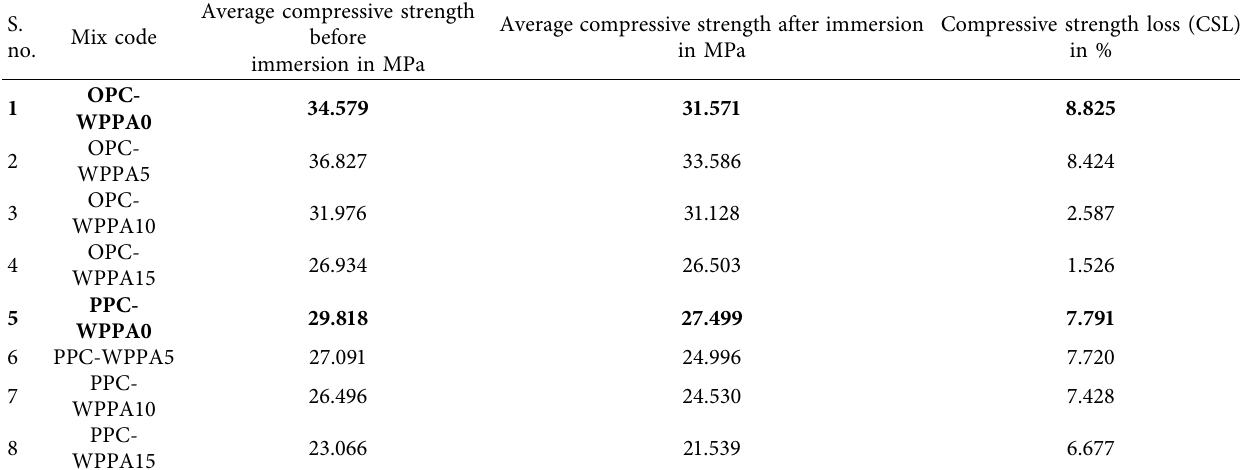
Table 15: Compressive strength loss (CSL) of OPC-WPPA and PPC-WPPA concrete cured in 2% sulfuric acid solution. S.